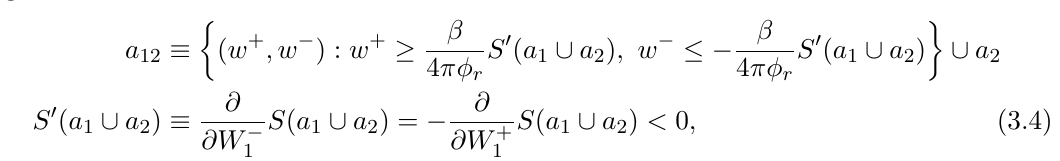
and a are also 1 2